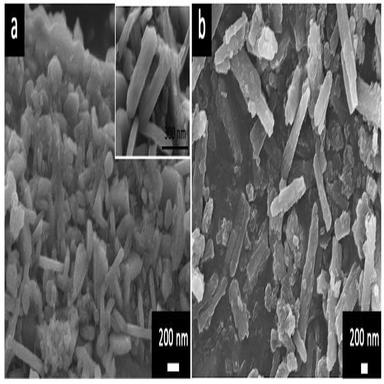
The SEM images of Li1.2Ni0.15Co0.1Mn0.55O2 (a) CLNs and (b) AMs after the rate performance test.